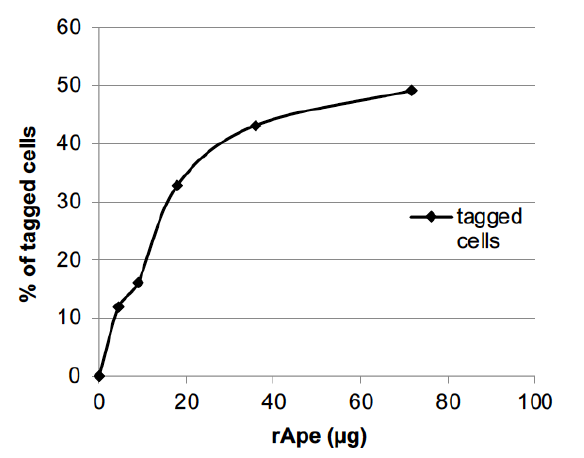
Figure 5. rApe attaches to the host cells. Different concentrations of rApe tagged with GFP were incubated with BAEC. Adherence of GFP-rApe to prefixed BAEC was evaluated by flow cytometry and showed a dose-effect relationship up to 36 µg of rApe. Fluorescent-labelled cells quantified by flow cytometry are represented in % for each concentration point. Auto-fluorescence was evaluated with cells without recombinant